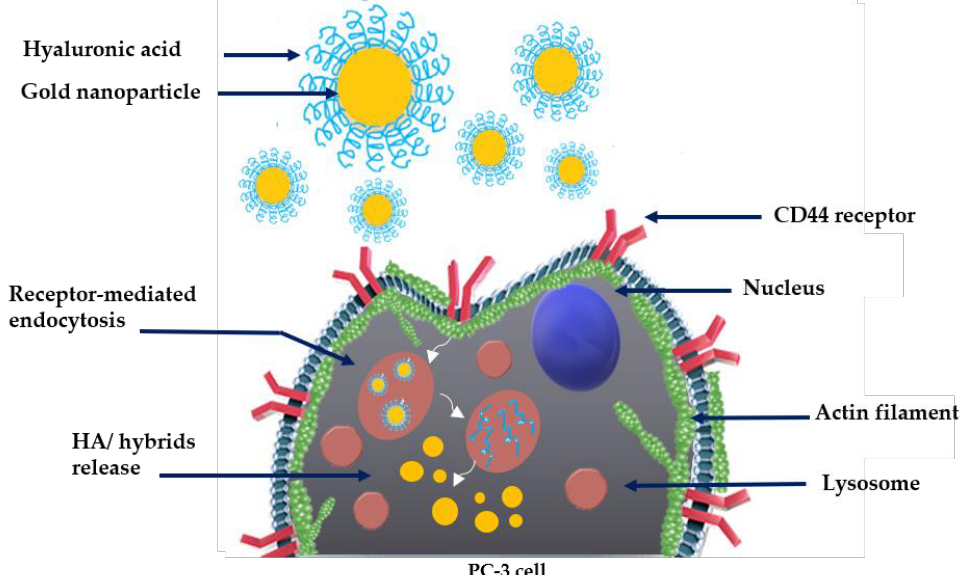
Figure 13. Schematic illustration of cellular uptake and intracellular trafficking: HA–AuNP hybrids interaction with lysosomes and cytoskeletal actin via CD44–HA site-specific binding on PC-3 tumor